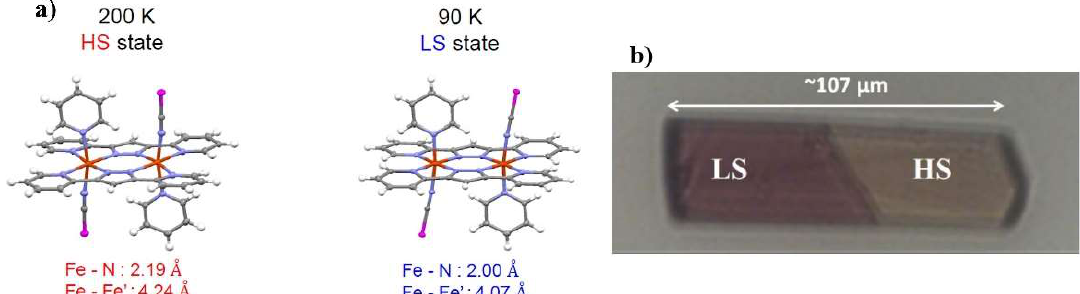
Figure 1. ( a ) Molecular structure of the [{Fe(NCSe)(py) 2 } 2 (m-bpypz)] molecule in the low-spin (LS) and high-spin (HS) states. The red and blue bonds are the most affected during the spin transition. The red dots represent Fe atoms, while the blue (gray) ones are N (C). The white and purple dots are hydrogen and Se atoms, respectively. The Fe–N distance increases by about 10% at the transition. ( b ) Transmission image of the single crystal [{Fe(NCSe)(py) 2 } 2 (m-bpypz)] in the course of the spin transition on heating at T = 110.5 K and intensity I = 21 mW cm −2 . The crystal size (length × width × thickness) is ~107 µm × 29 µm × 10 µm.